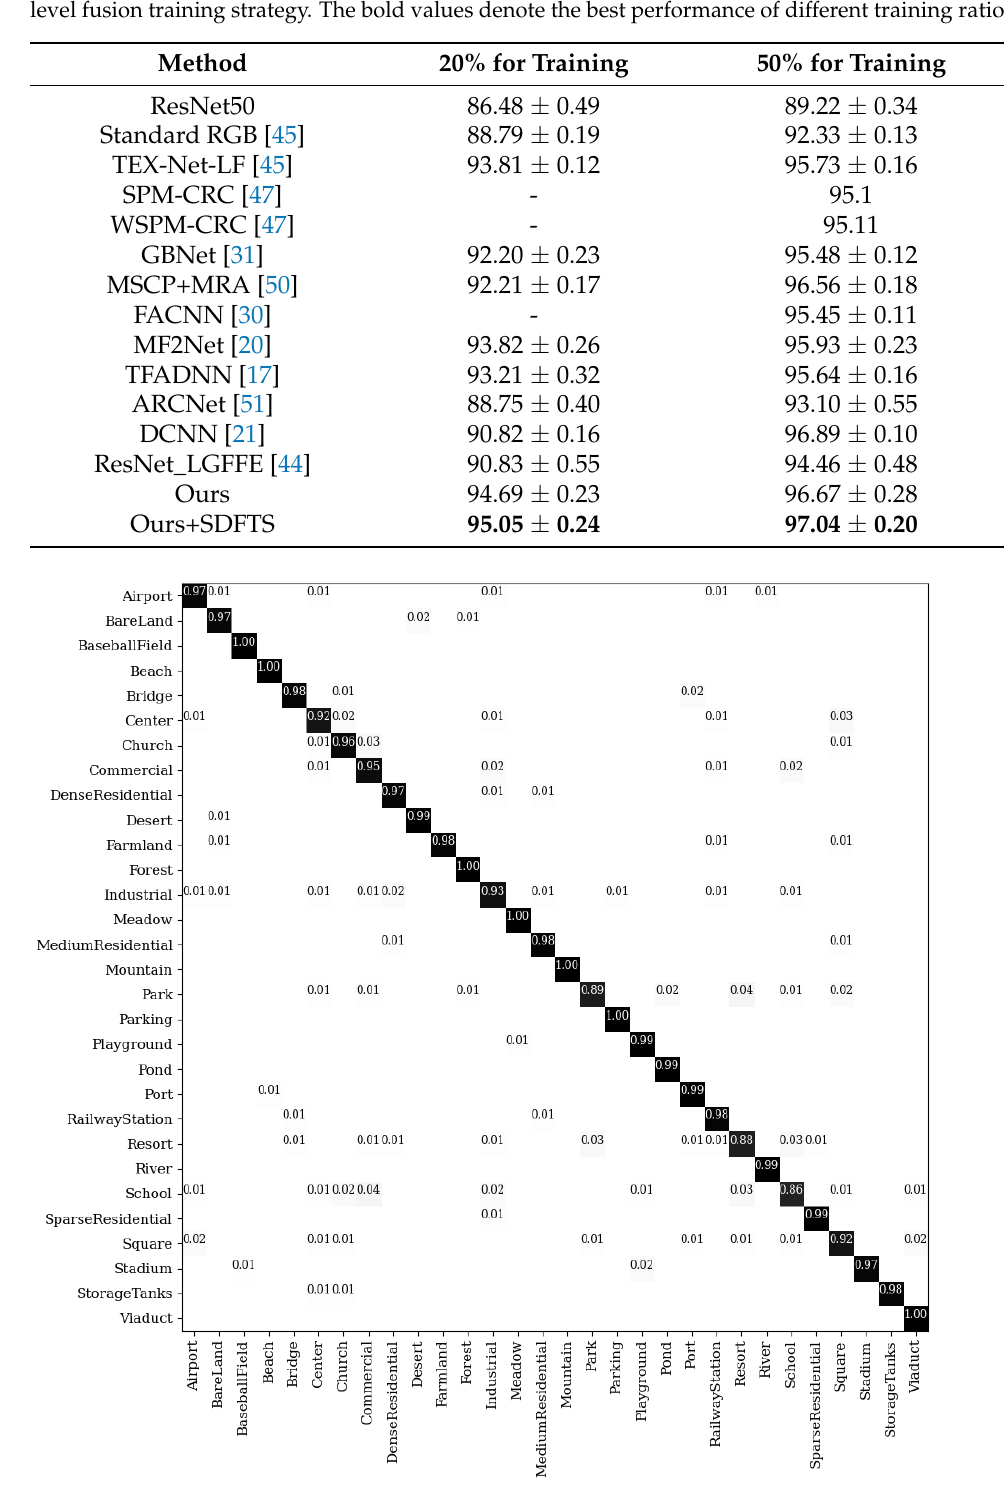
Figure 10. The confusion matrix on the AID dataset under the 50% training